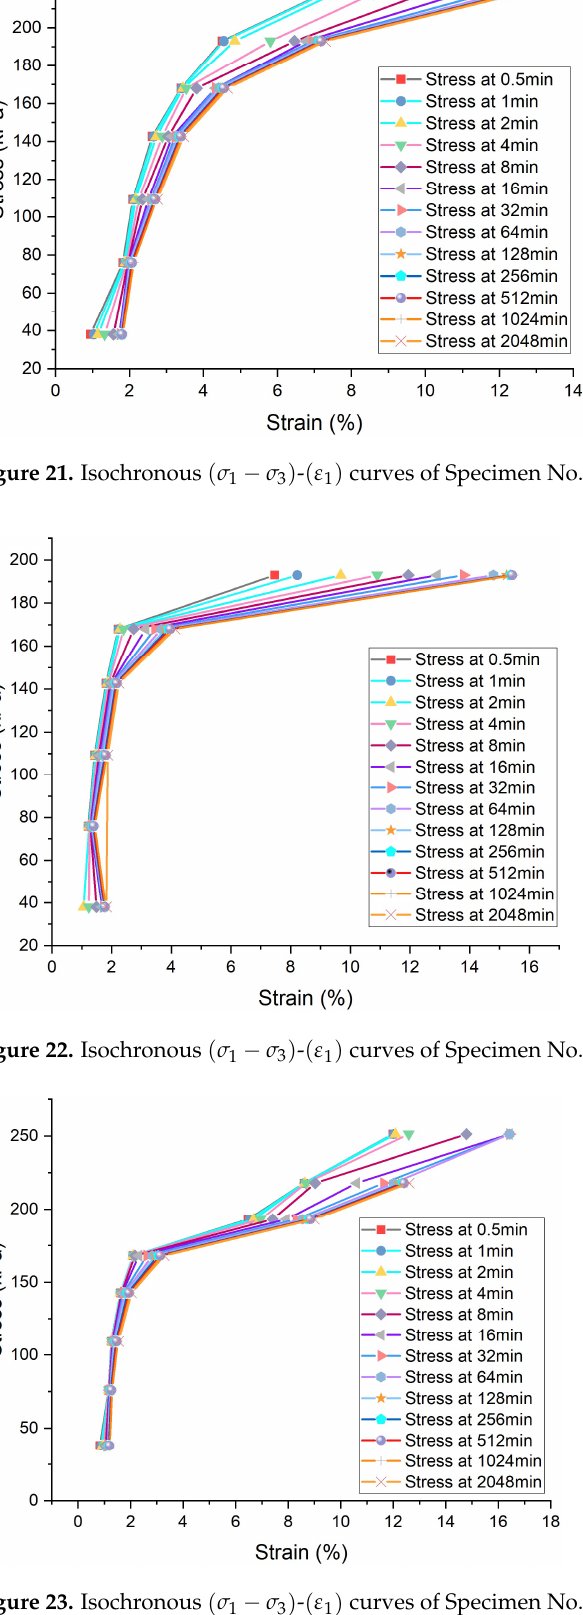
Figure 23. Isochronous (𝜎 (cid:2869) − 𝜎 (cid:2871) ) - (𝜀 (cid:2869) ) curves of Specimen No. 25, 11 FTHs.